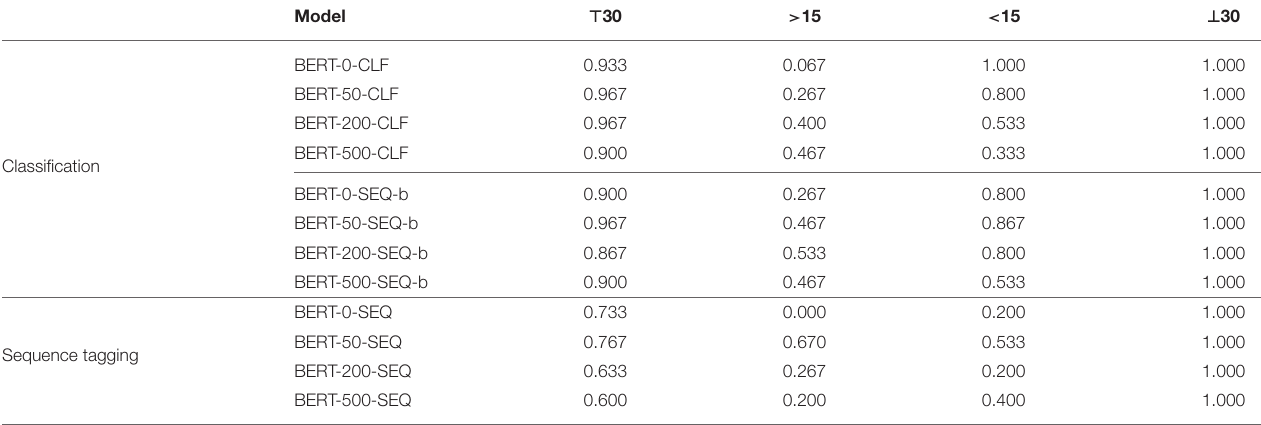
TABLE 7 | Accuracy on each sample on the SIG dataset.